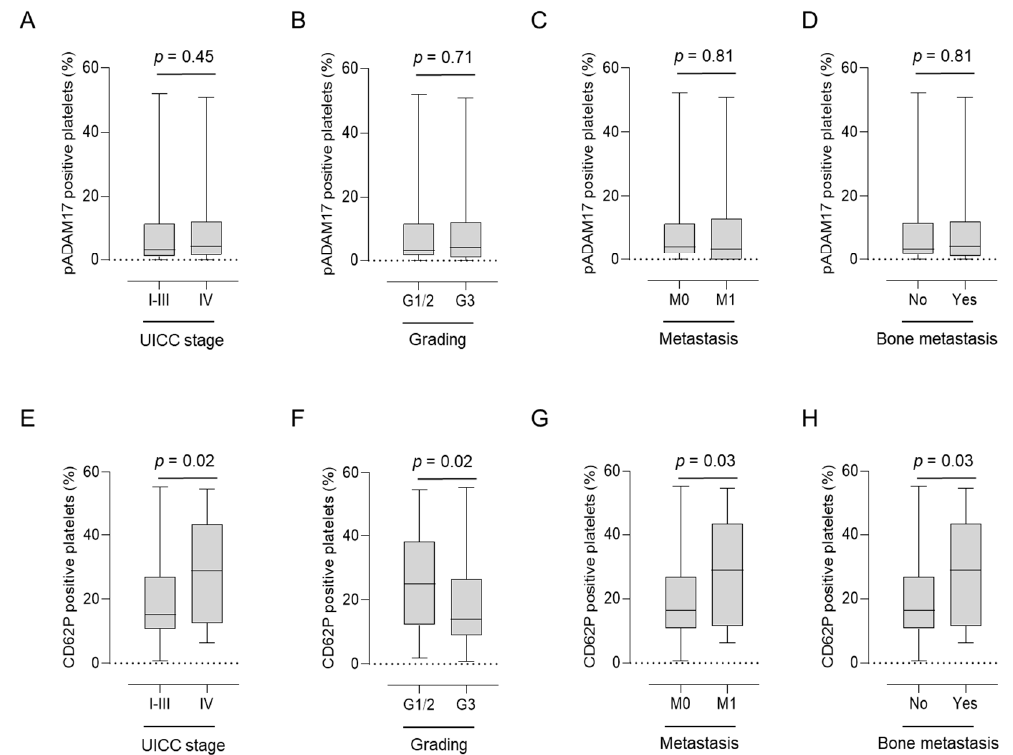
Figure 2. Association of pADAM17 ( A – D ) and platelet-CD62P ( E – H ) expression levels of 70 breast cancer patients with regards to Union for International Cancer Control (UICC) stage ( A , E ), G grade ( B , F ), M stage ( C , G ), and the occurrence of bone metastasis ( D , H ).